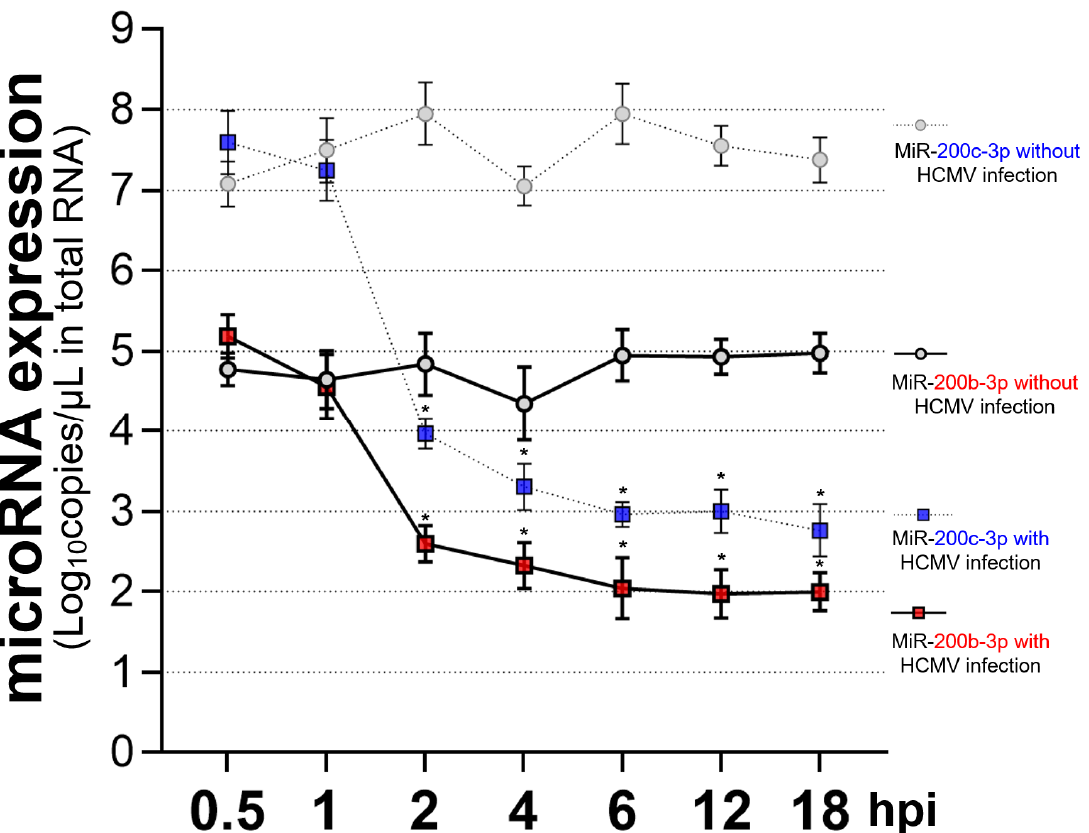
Figure 4. Dynamic changes in the expression of endogenous miR ‐ 200b ‐ 3p and miR ‐ 200c ‐ 3p during early lytic HCMV replication. Expression of miR ‐ 200b ‐ 3p and miR ‐ 200c ‐ 3p quantified using RT ‐ PCR at indicated hpi in lysates of HFF ‐ 1 cells (1 × 10 6 /well) infected with or without the HCMV Towne strain at an MOI of 0.1. * p < 0.001, compared with cells without HCMV infection 2.5. The Expression of miR ‐ 200b ‐ 3p and miR ‐ 200c ‐ 3p Is Not Downregulated during Latent HCMV Infection and Exogenous Inhibition of miRNA Expression Induced IE Expression and Virus Replication during Latency